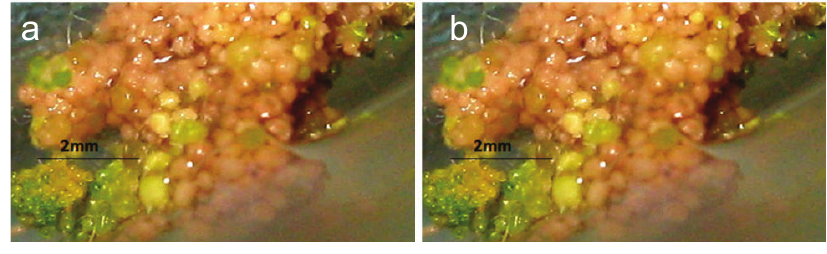
Figure 5. (a) PLB development on media with 0.1 mg/L TDZ and (b) 0.3 mg/L TDZ showing a high level of necrosis.